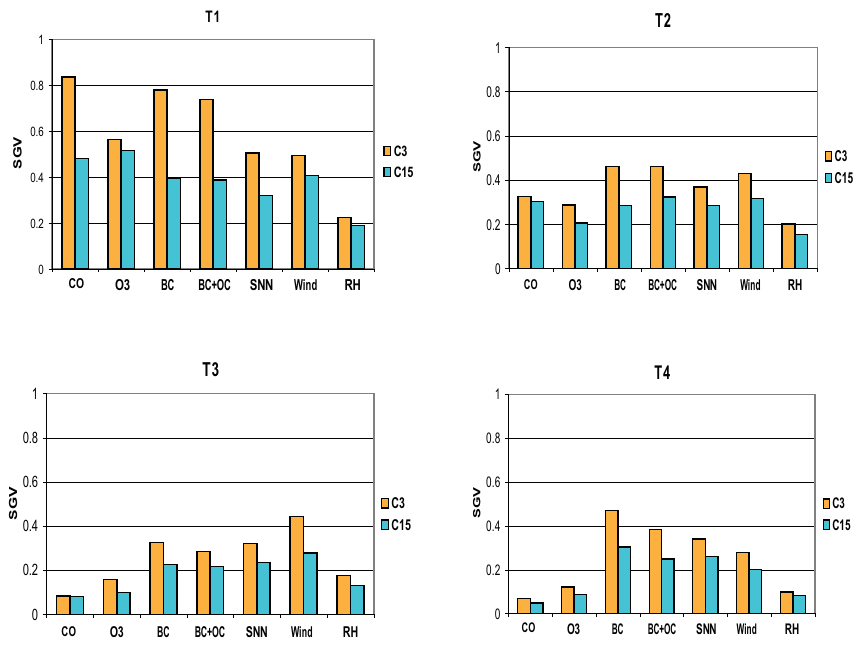
Fig. 14. Comparison of SGV in C3 and C15 simulations over sites T1, T2, T3, and T4 for CO, O3, BC, BC+OC, SNN, wind speed, and RH at the surface. The SGV is calculated over the time period 5–30 March